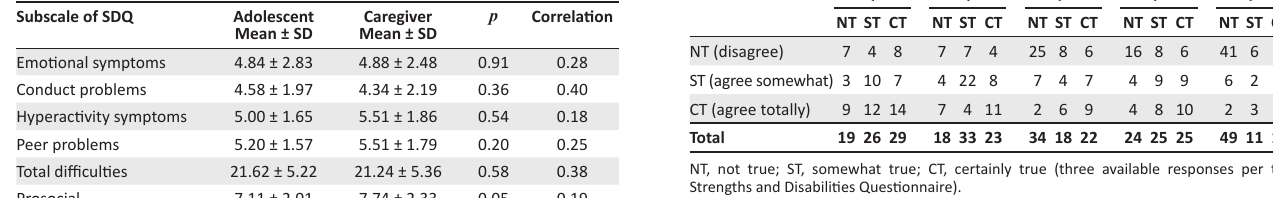
TABLE 2: The Strengths and Disabilities Questionnaire scores for all adolescents, and their parents.